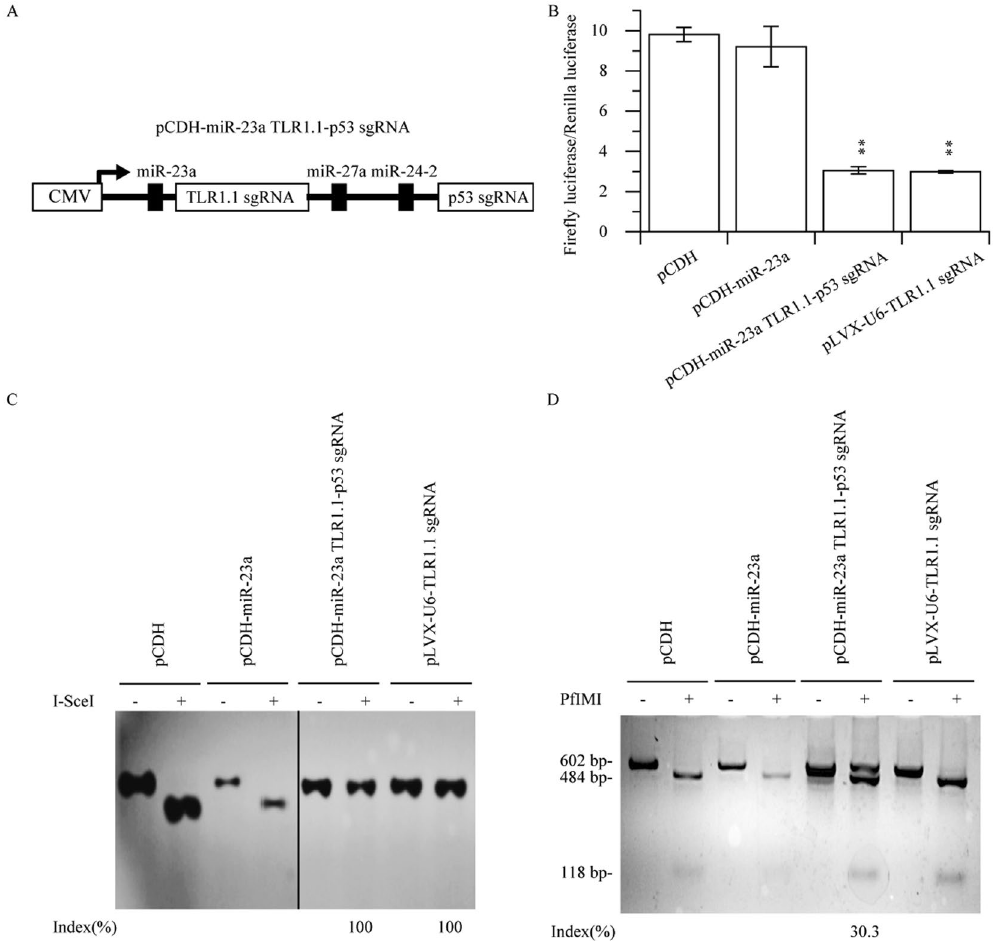
Figure 6. Multiplex genome editing mediated by miRNA based sgRNA. ( A ) Schematic overview of pCDH-miR- 23a TLR1.1-p53 sgRNA construction. pCDH-miR-23a TLR1.1-p53 sgRNA or corresponding control was co- transfected into 293T cell with pGL3-control NHEJ V2, pLentiCRISPR, and pRL-TK. 6 days after transfection, cells were harvested in the passive lysis buffer for luciferase assay ( B ). Where a portion of the cell lysate was digested by proteinase K and then served as PCR template in I-SceI nuclease assay ( C ). To demonstrate the nuclease activity of p53 sgRNA, total RNA was extracted from aforementioned cells using Trizol regent, and then was reverse transcribed to serves as a template to amplified p53 cDNA and subjected to PfIMI nuclease assay, which showed that pCDH-miR-23a TLR1.1-p53 sgRNA could serve as a tool to knock out